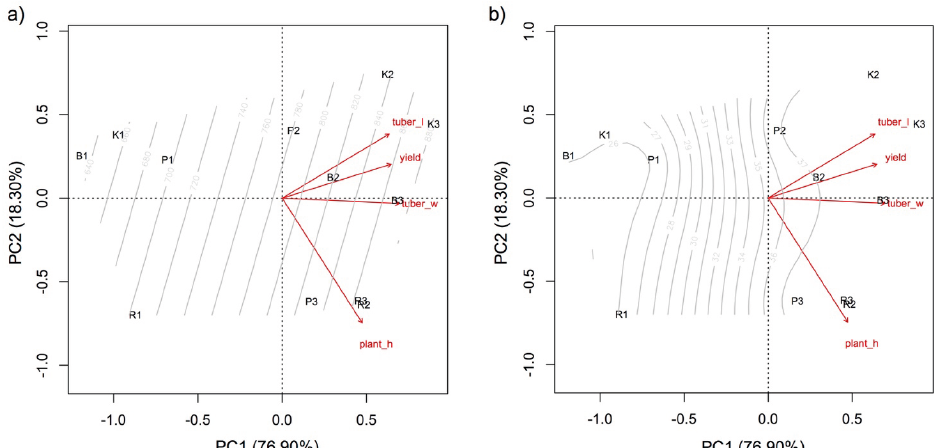
Fig. 6: PCA ordination biplots of potato genotypes (P, Prugnona; B, Bianca; R, Rubra Spes; K, Kennebec) cultivated in the three experimental fields (1, field 1; 2, field 2; 3, field 3), overlapped with elevation (a) and soil skeleton contour lines. Key: tuber_l, tuber length; tuber_w, tuber width; plant_h, plant height; yield, yield of